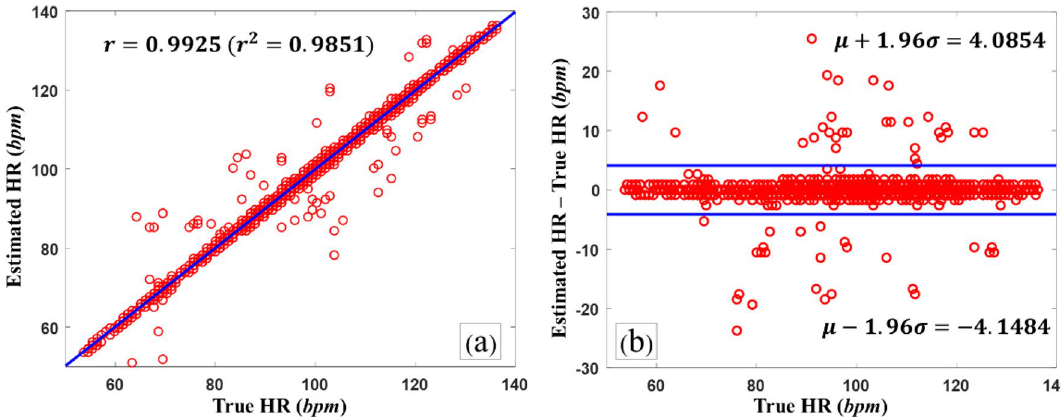
Figure 6. ( a ) Pearson correlations between estimated HRs and true HRs (r = 0.9925). ( b ) Bland–Altman plot (μ = − 0.0315 and σ = 2.1005).